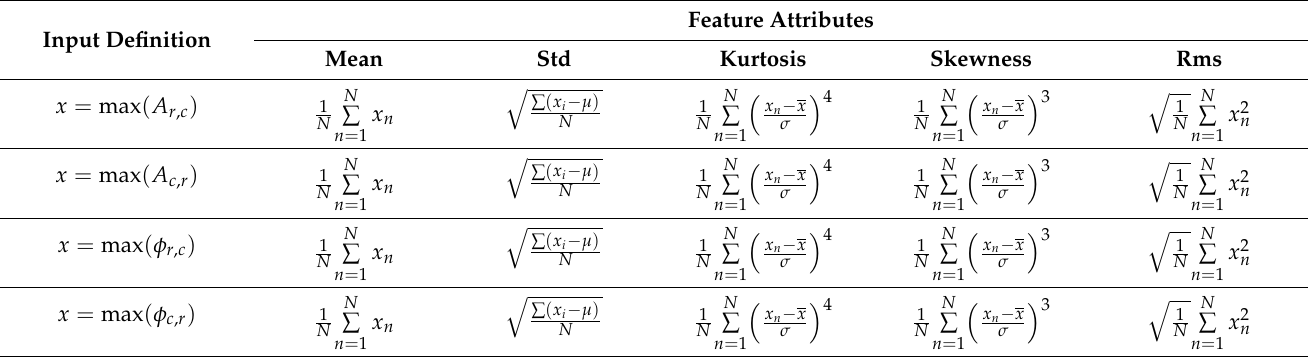
Table 1. Feature attributes for the SFP